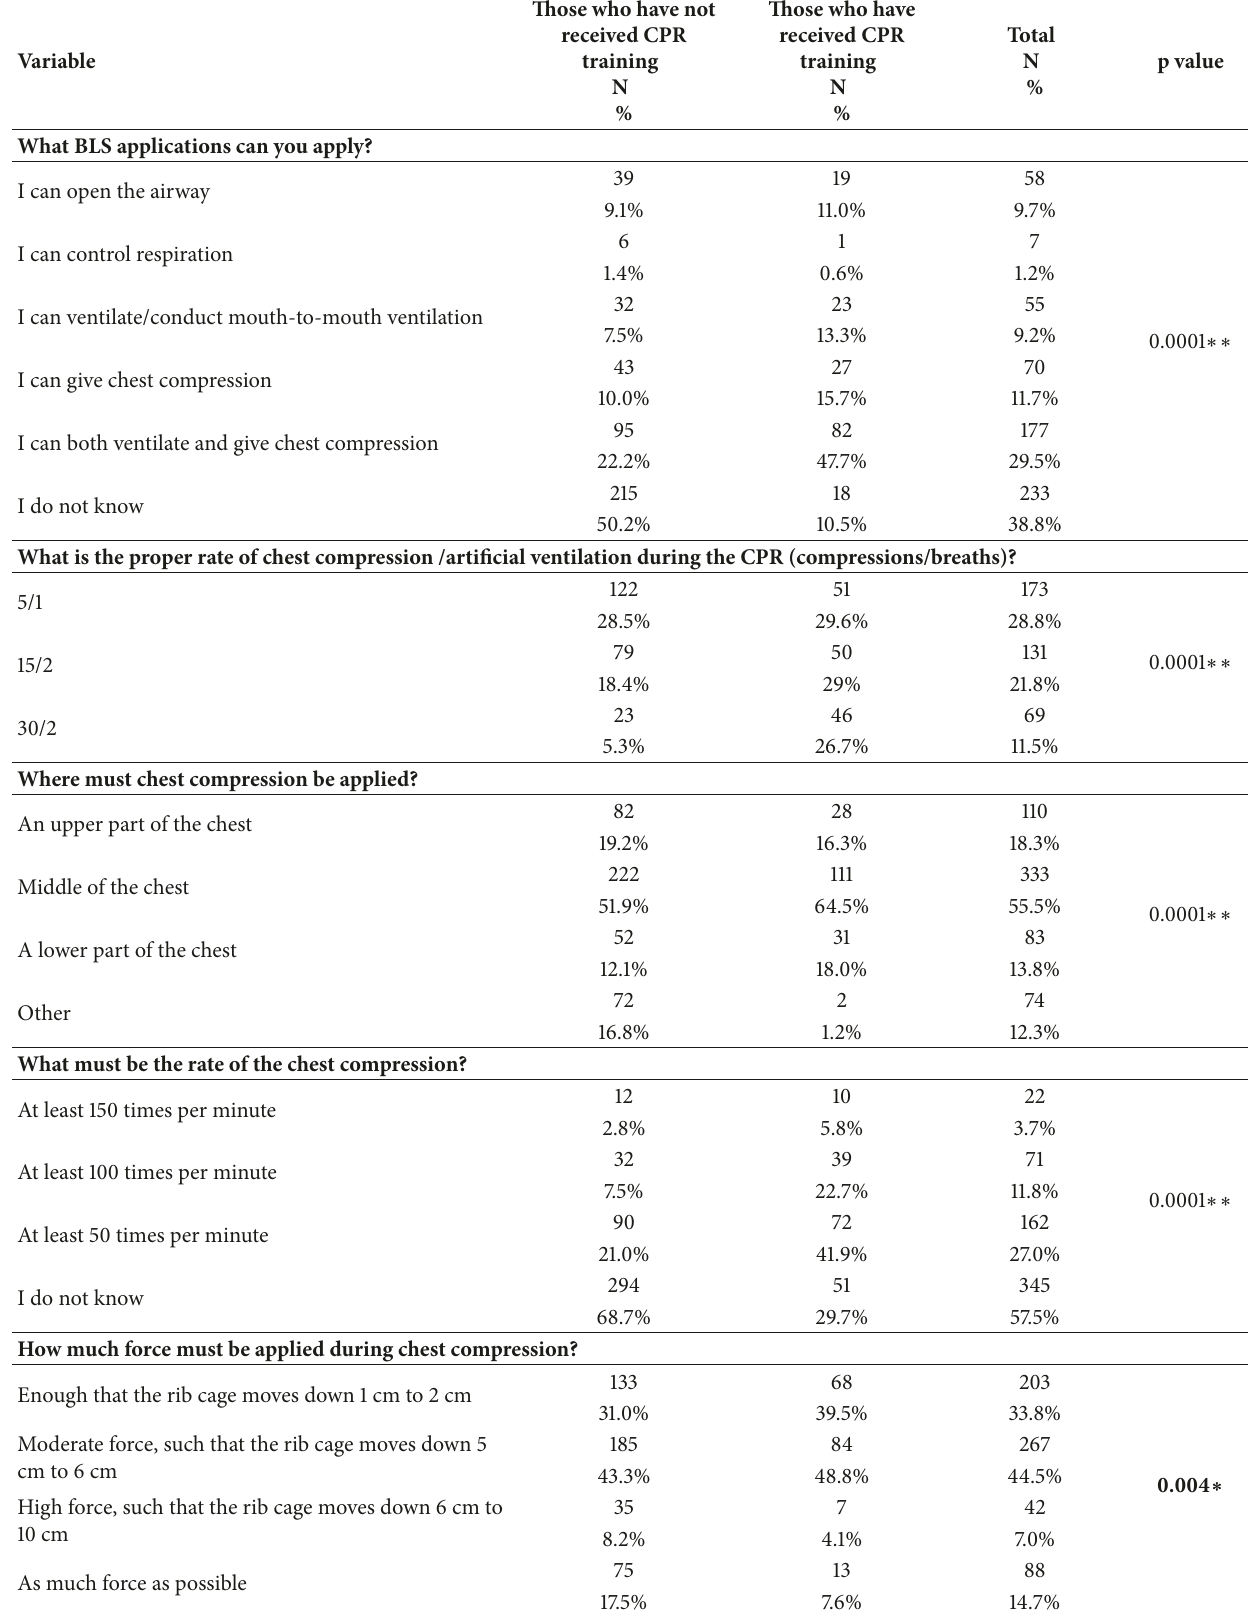
Table 10: Association of CPR application with previous CRP